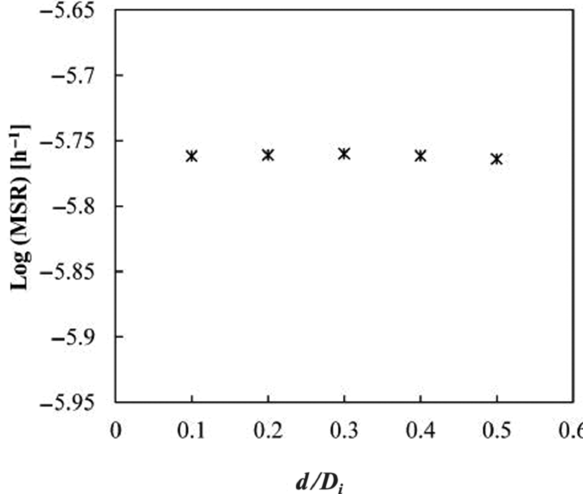
Figure 13: The effect of the TBS depth, d , on the minimum strain rate.